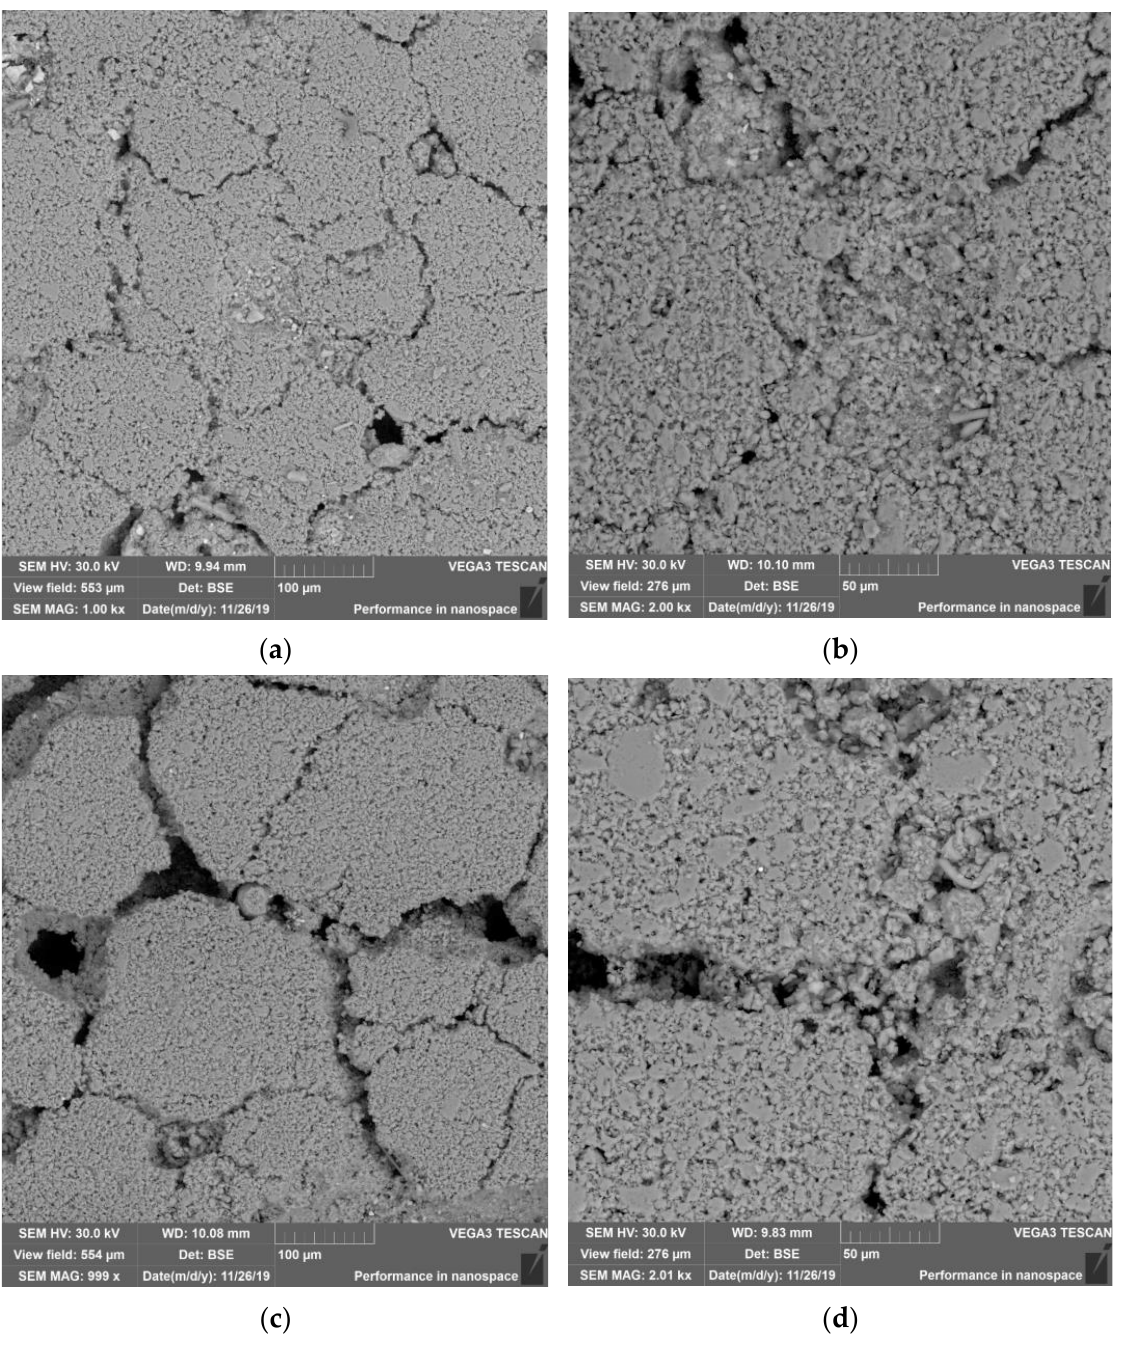
Figure 22. Ex situ SEM BSE images of accommodative compaction bands formed by densification of fragments in the interblock spaces of Sample #1 ( a , b ) and Sample #4 ( c , d ). If the vector field is scanned along some contour and in each current position the circulation value is equal to Γ . Then, in the case when the contour completely falls into the vortex region, Γ = const